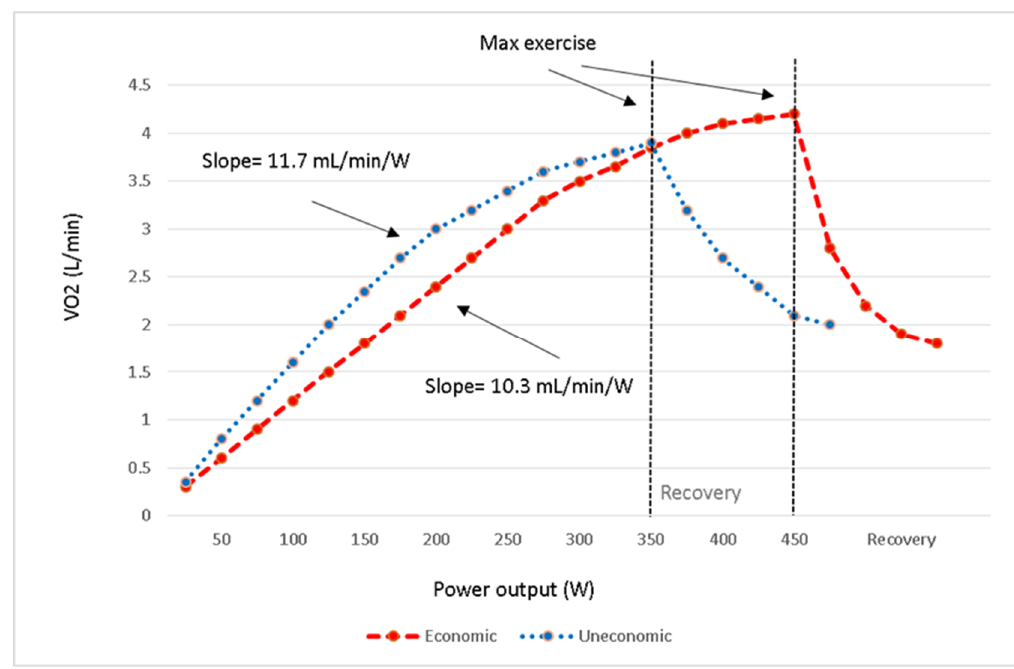
Figure 1. Athletes with different exercise economy as shown by VO 2 /workload responses to incremental exercise.